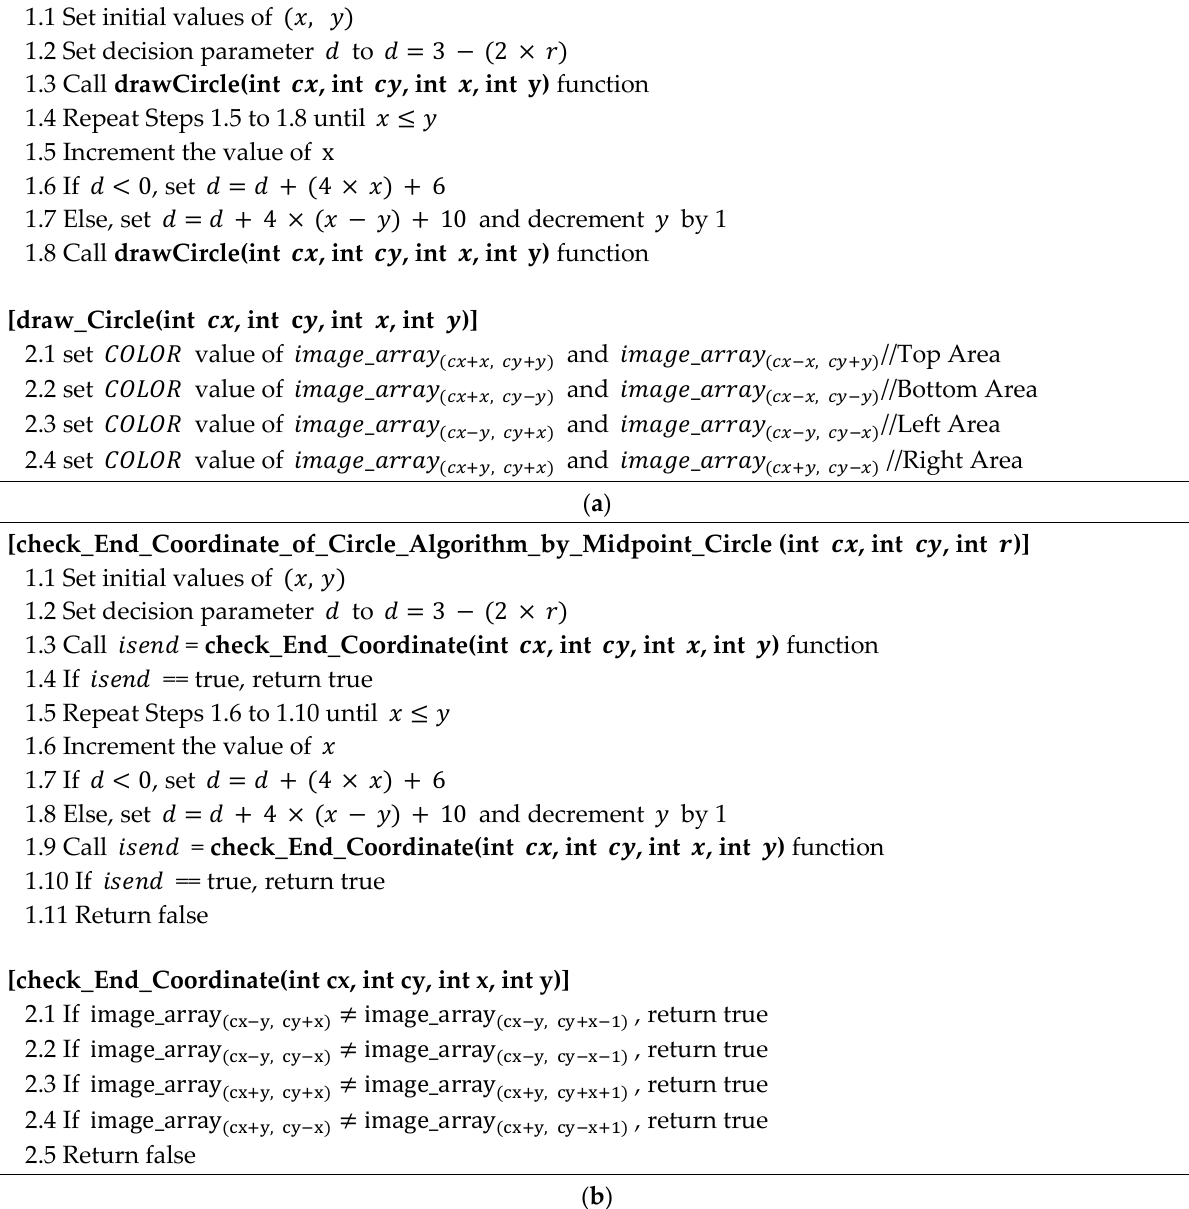
Figure 19. Midpoint circle algorithm vs. the check End Coordinate of the Circle algorithm. ( a ) Midpoint circle algorithm. ( b ) Check End Coordinate of the Circle algorithm for the midpoint circle.